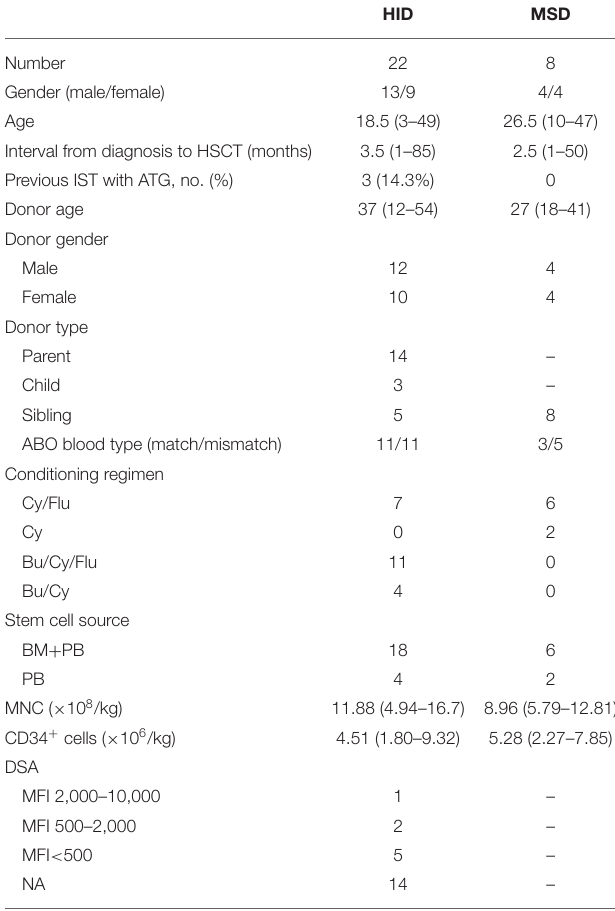
TABLE 1 | Clinical characteristics of the